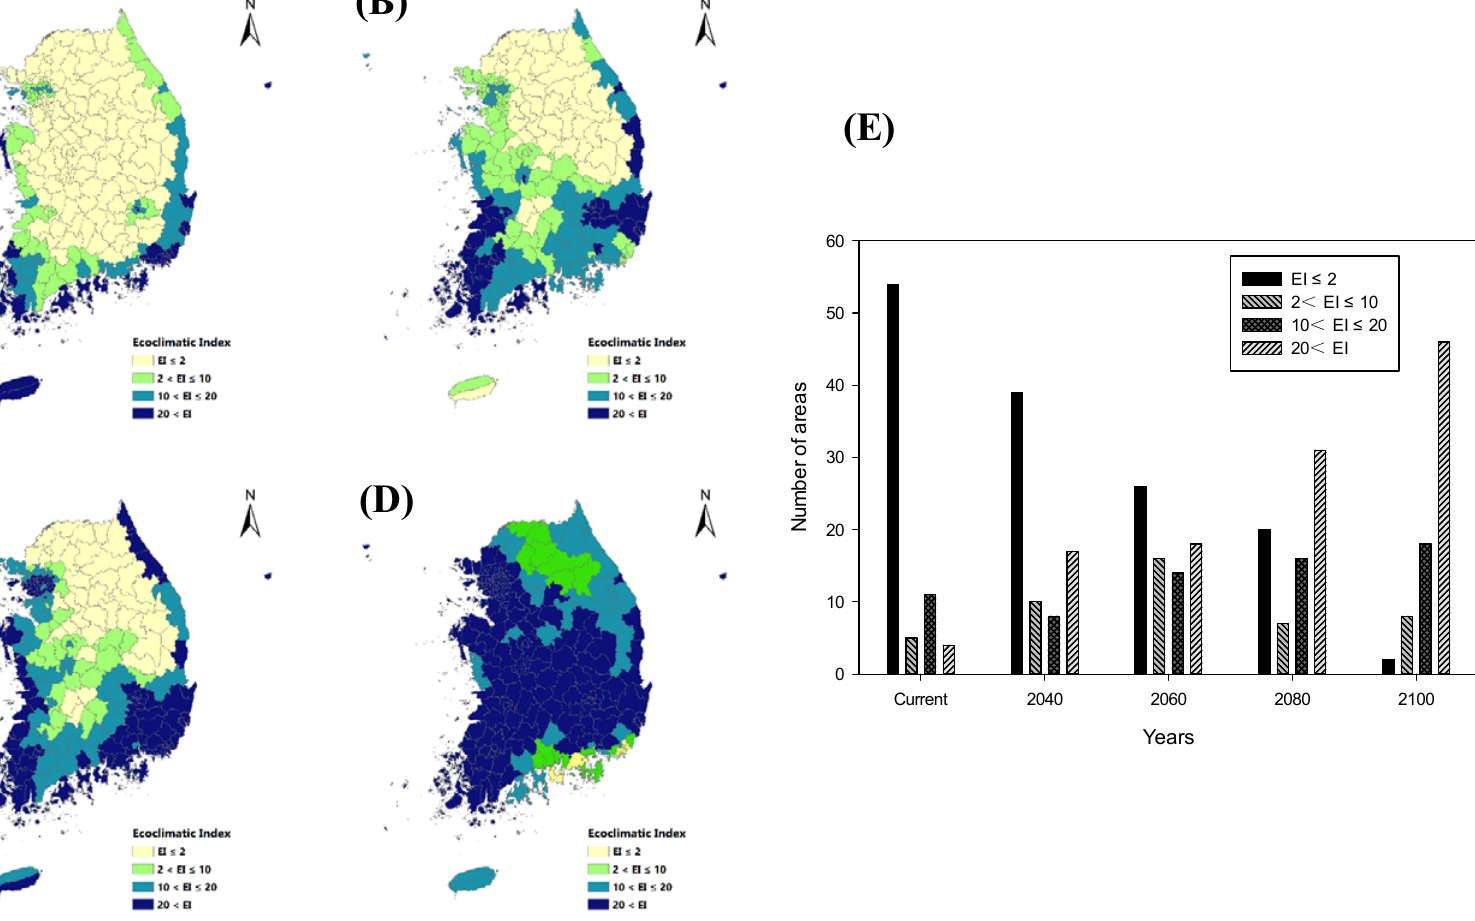
Figure 2. Predicted distribution of red imported fire ant (( A ): 2040, ( B ): 2060, ( C ): 2800, ( D ): 2100), and changes in EI values by the number of areas and times in response to climate change ( E ).